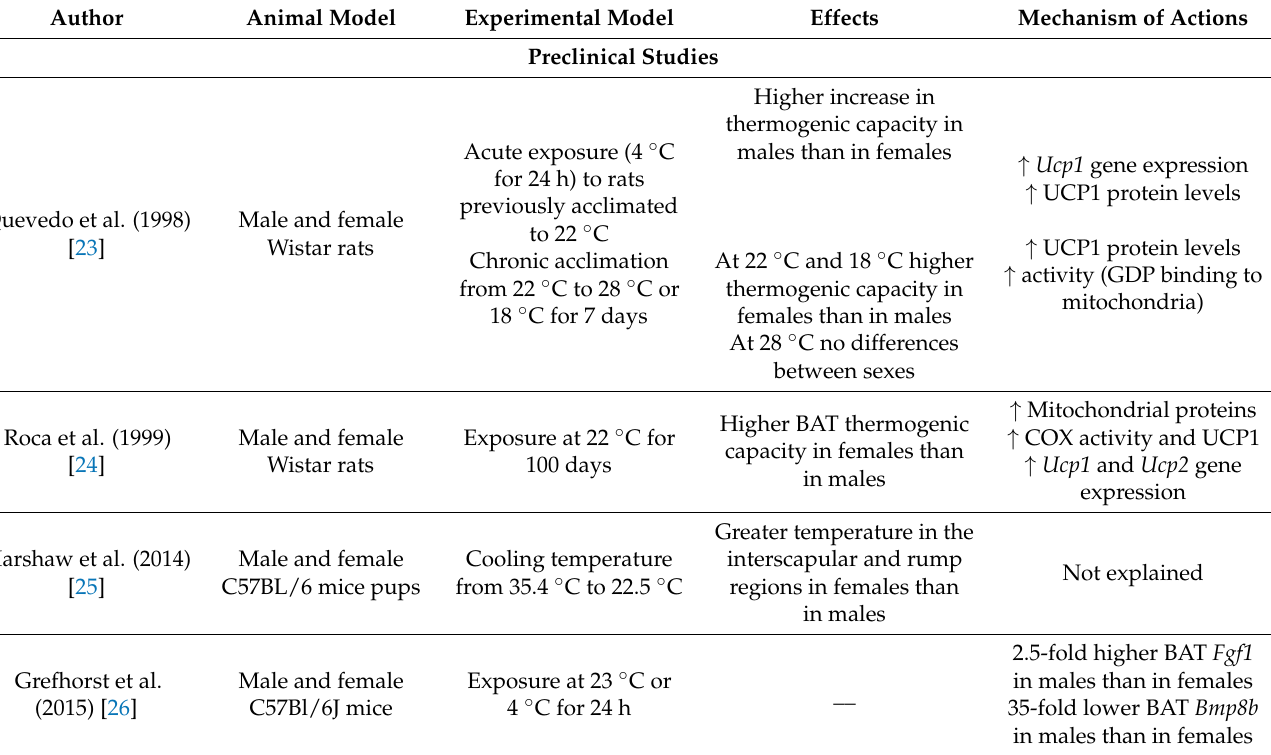
Figure 2. Mechanism of the UCP1 protein activation in BAT. β -adrenergic receptor induces the activation of Gs protein, leading to the production of cyclic adenosine monophosphate (cAMP) by means of adenylate cyclase (AC). This metabolic messenger activates cAMP-dependent protein kinase (PKA), which in turn stimulates hormone-sensitive lipase (HSL), the lipase that acts on diglycerides to produce free fatty acids and monoglycerides. Free fatty acids are then available to be oxidized in mitochondria. ATP, adenosine triphosphate; ADP, adenosine diphosphate; BAT, brown adipose tissue; UCP1, uncoupling protein 1. Table 1. Sexual dimorphism in thermogenesis induced by cold in preclinical and clinical studies.